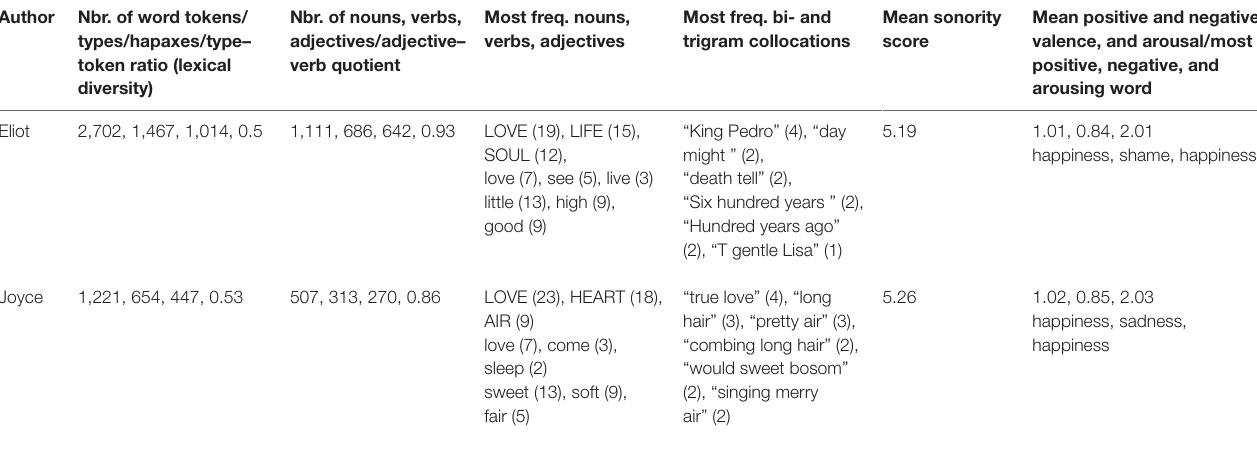
Table 4 | Some exemplary statistics for two poems.